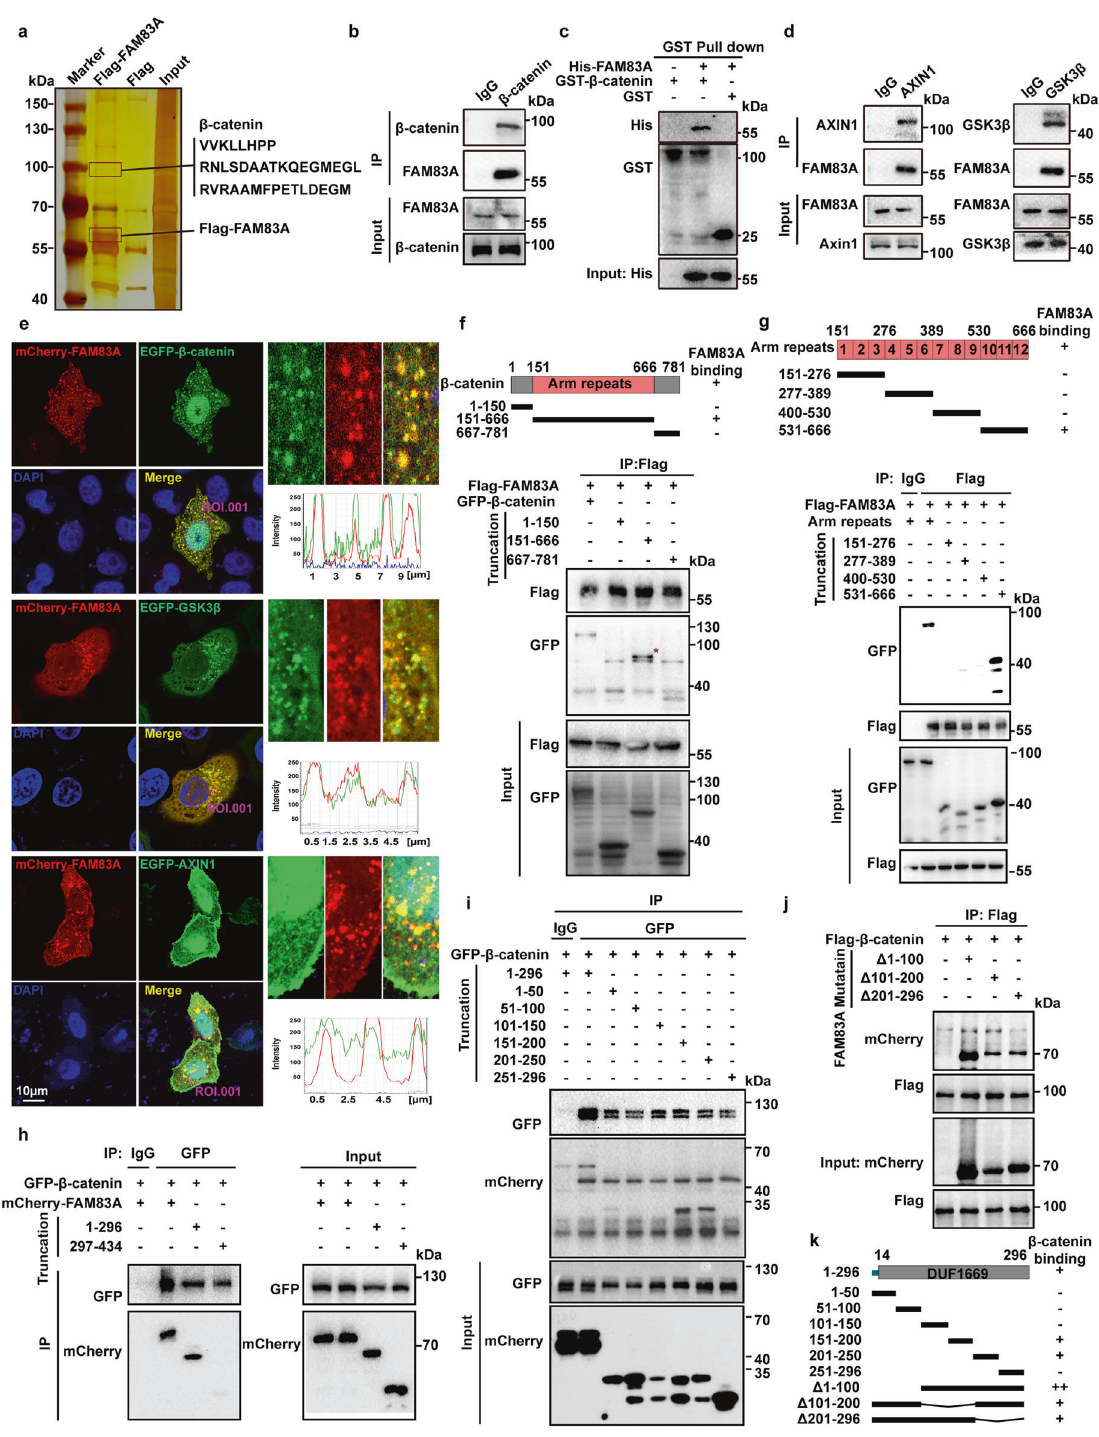
Fig. 1 FAM83A is identi fi ed as a new component of the cytoplasmic β -catenin destruction complex. a Silver staining of immunoprecipitate using Flag antibody from HEK293T cell lysates transfected with Flag-tagged FAM83A. b The interaction between endogenous FAM83A and β -catenin in pancreatic cancer PANC-1 cells. Protein interactions were analyzed by western blotting. c Externally puri fi ed GST-tagged full- length β -catenin was incubated with externally puri fi ed His-tagged FAM83A, the mixture was pulled down by GST beads and then the precipitates were subjected to western blotting. d The interaction between endogenous FAM83A and the components of β -catenin destructive complex AXIN1 and GSK3 β in PANC-1 cells. Protein interactions were analyzed by western blotting. e The co-localization of mCherry-tagged FAM83A and EGFP-tagged β -catenin, GSK3 β , and AXIN1 in HeLa cells were analyzed with confocal microscopy. f , g HEK293T cells were transfected with the β -catenin truncation mutations indicated for 48 h and then harvested for IP and western blotting analysis. The schematic diagram of β -catenin truncation generation and FAM83A- β -catenin mutants interacting domain were shown. h – k HEK293T cells were transfected with the FAM83A truncation or deletion mutations indicated for 48 h and then harvested for IP and western blotting analysis. The schematic diagram of FAM83A truncation and deletion generation and β -catenin-FAM83A mutants interacting domain were shown. Scale bars: 10 µm Signal Transduction and Targeted Therapy (2023)